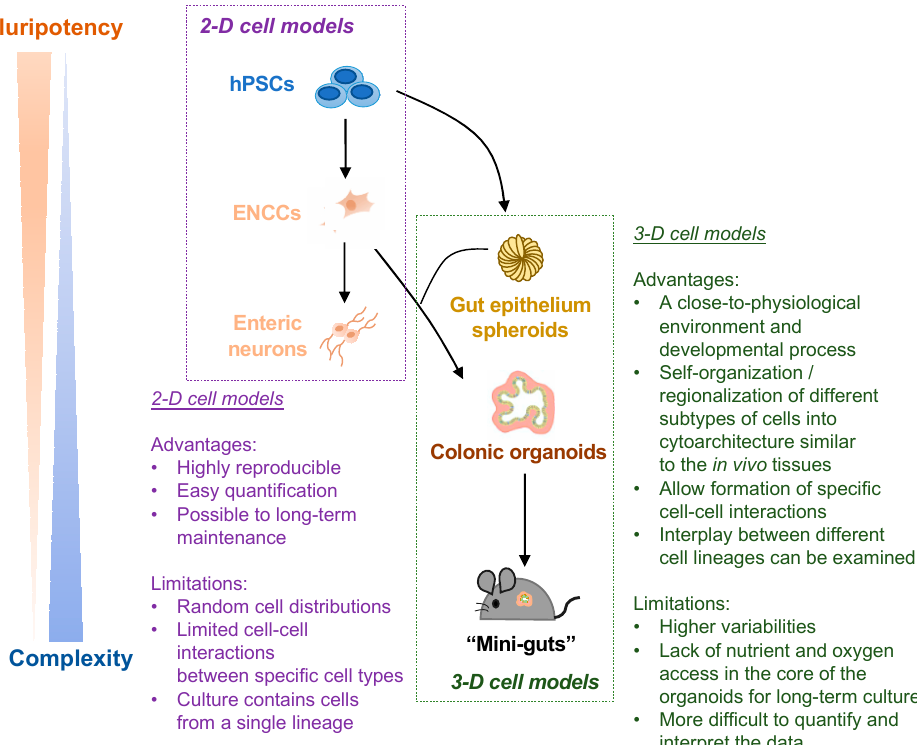
Figure 3. Schematic summary of the advantages and limitations of hPSC-derived 2-D and 3-D cell models of ENS. Both 2-D cell models (ENCCs and enteric neurons) and 3-D cell models (colonic organoids and “mini-guts”) are used for HSCR-related studies. The advantages and limitations of 2-D vs. 3-D cell models are listed.